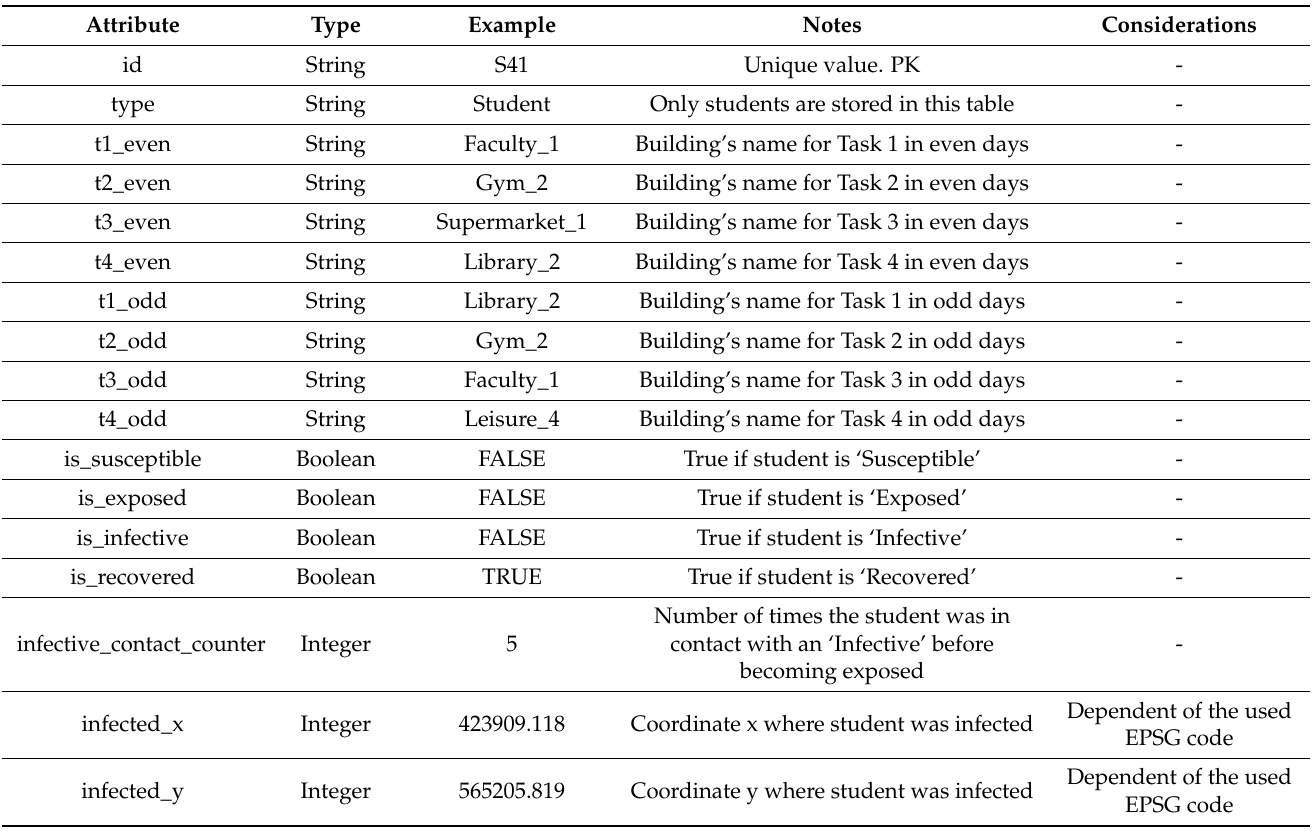
Table A8. Agents_after_simulations.csv attribute